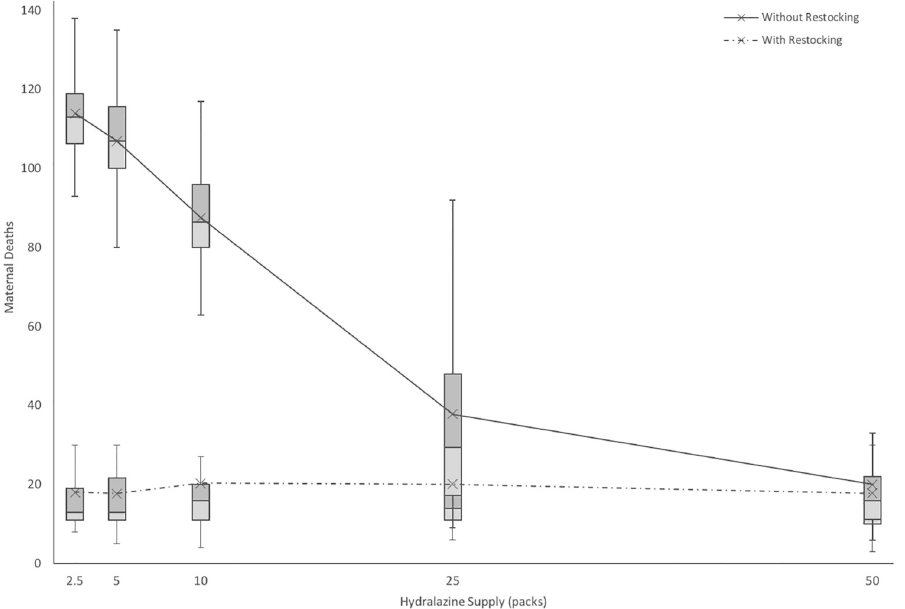
Fig 8. Impact of hydralazine inventory and supply frequency on maternal deaths over a 3-month period. Box plots exclude outliers and whiskers reflect local maxima and minima among n = 50 runs for each data point. Line plots reflect mean values for each data point, including outliers.